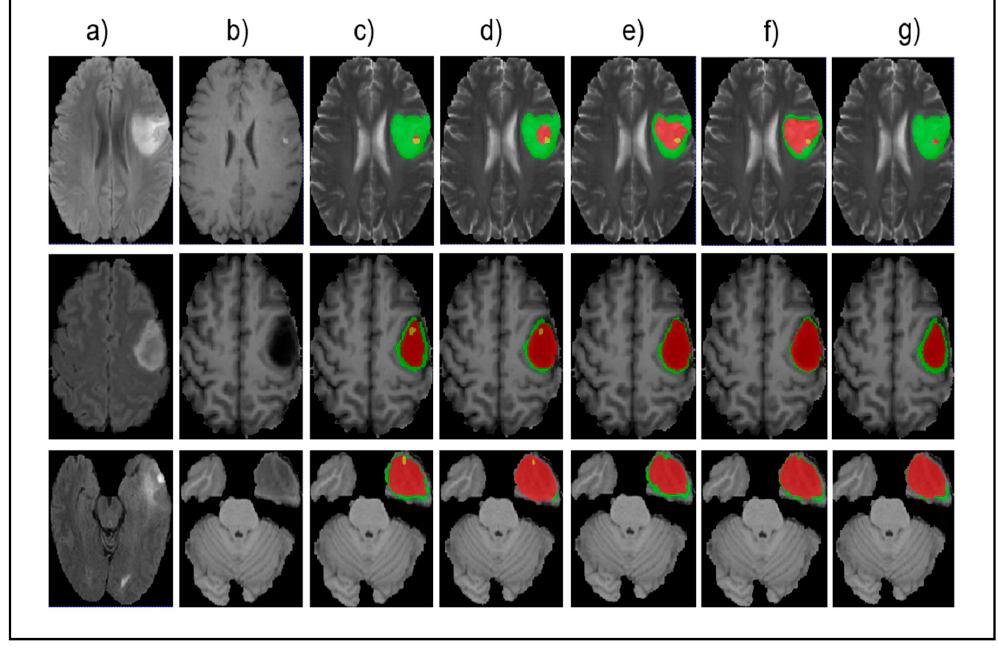
Figure 6. Dice similarity coefficient (DSC) stratified by tumor size.